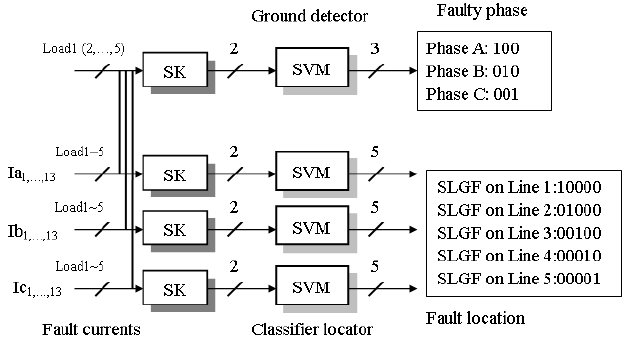
Figure 9. Protection scheme for proposed methods. SK: Skewness and Kurtosis; and SVM: support vector machine.